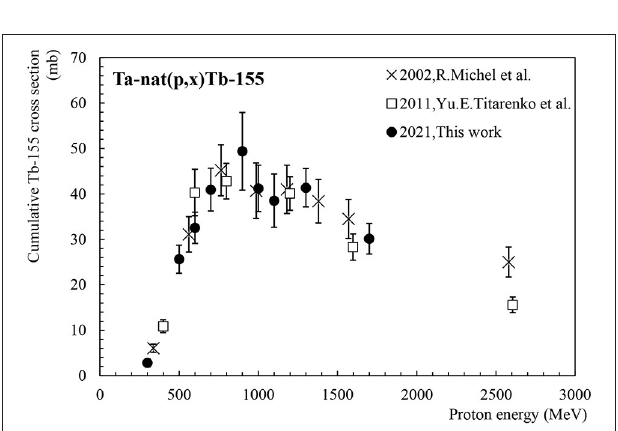
FIGURE 5 | Cumulative cross-section for Tb-155 production as a function of the proton beam energy.